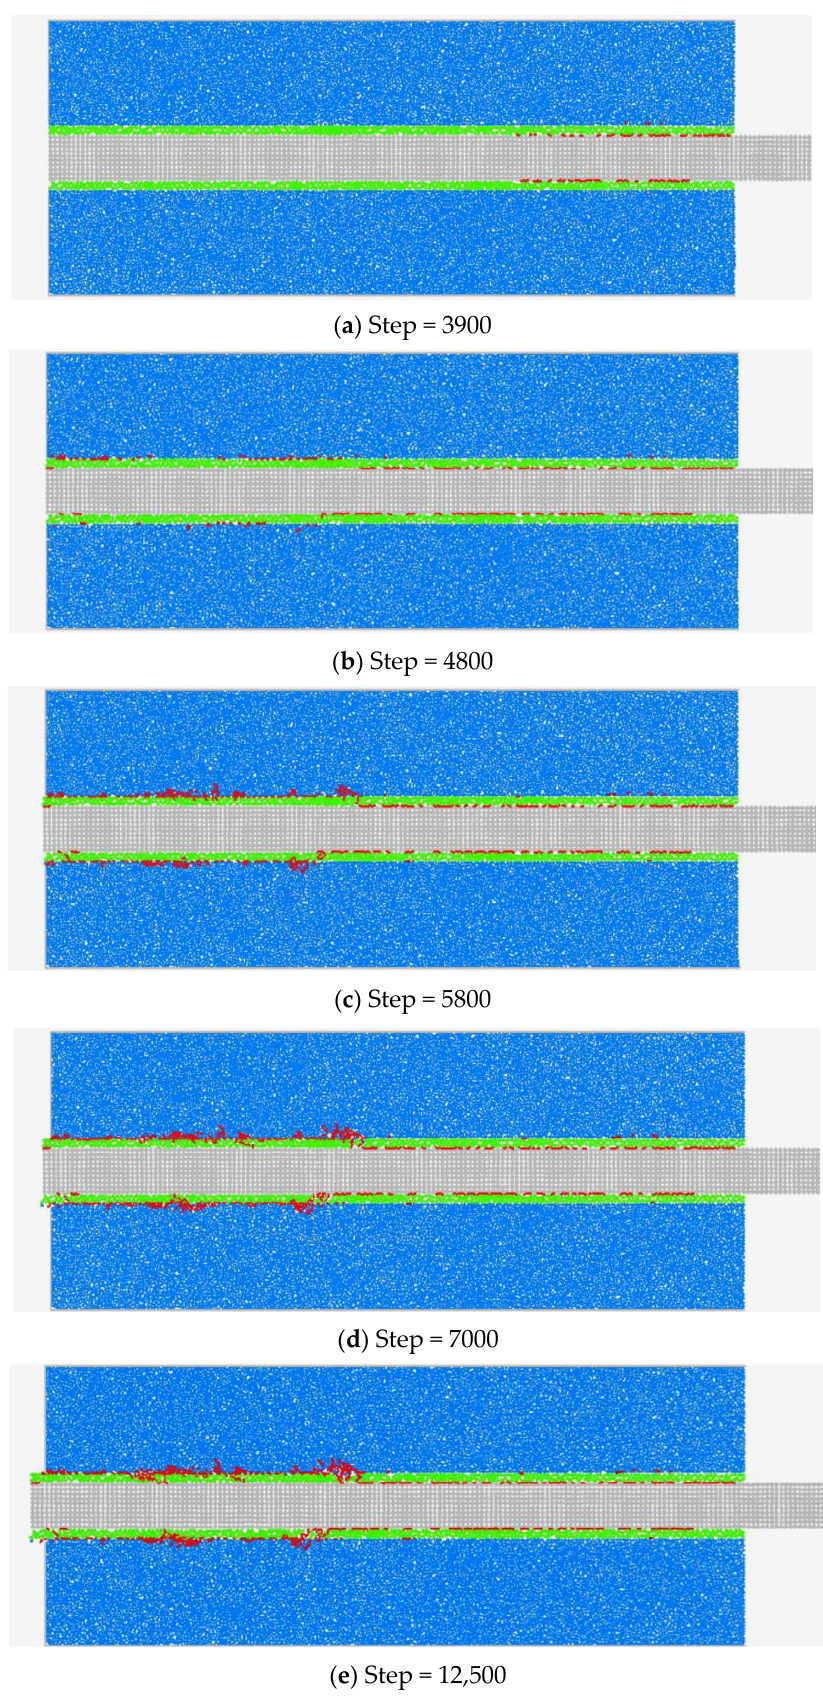
Figure 14. Evolution process of anchorage debonding.